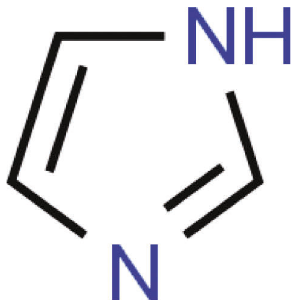
Figure 5: Imidazole (Drug identity: DB03366) bound to the short peptide NL.